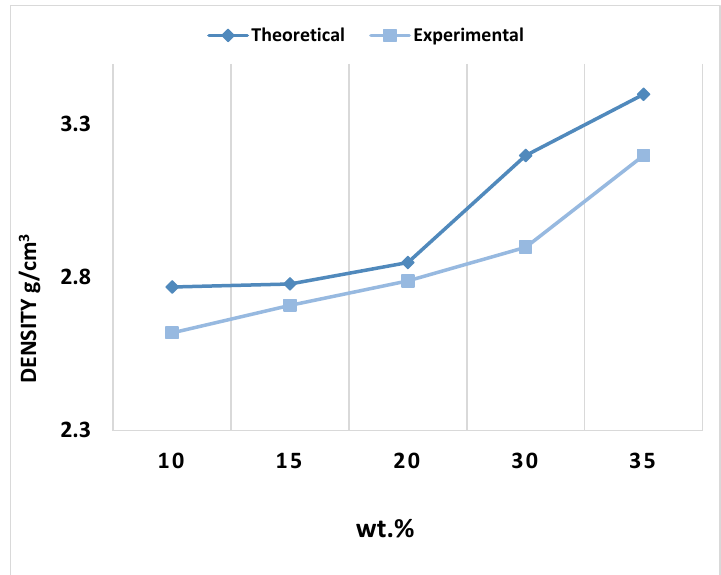
Figure 10. Theoretical and experimental densities of composites.